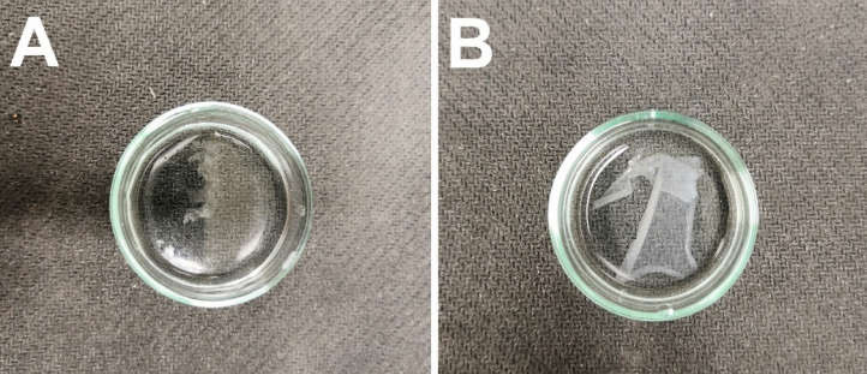
Figure 3. The fiber layers following soaking in distilled water. ( A ) The PVA/gelatin fiber layer. ( B ) The PVA/alginate fiber layer.